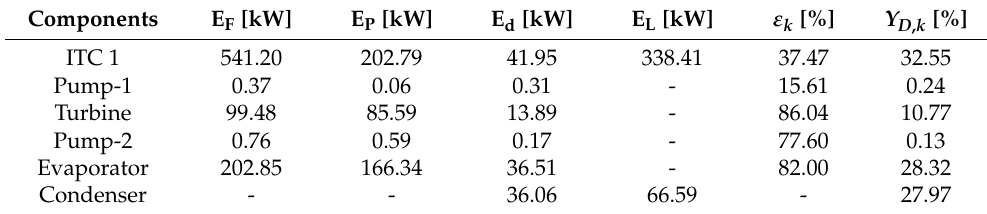
Table 8. Main results of the exergetic analysis for each